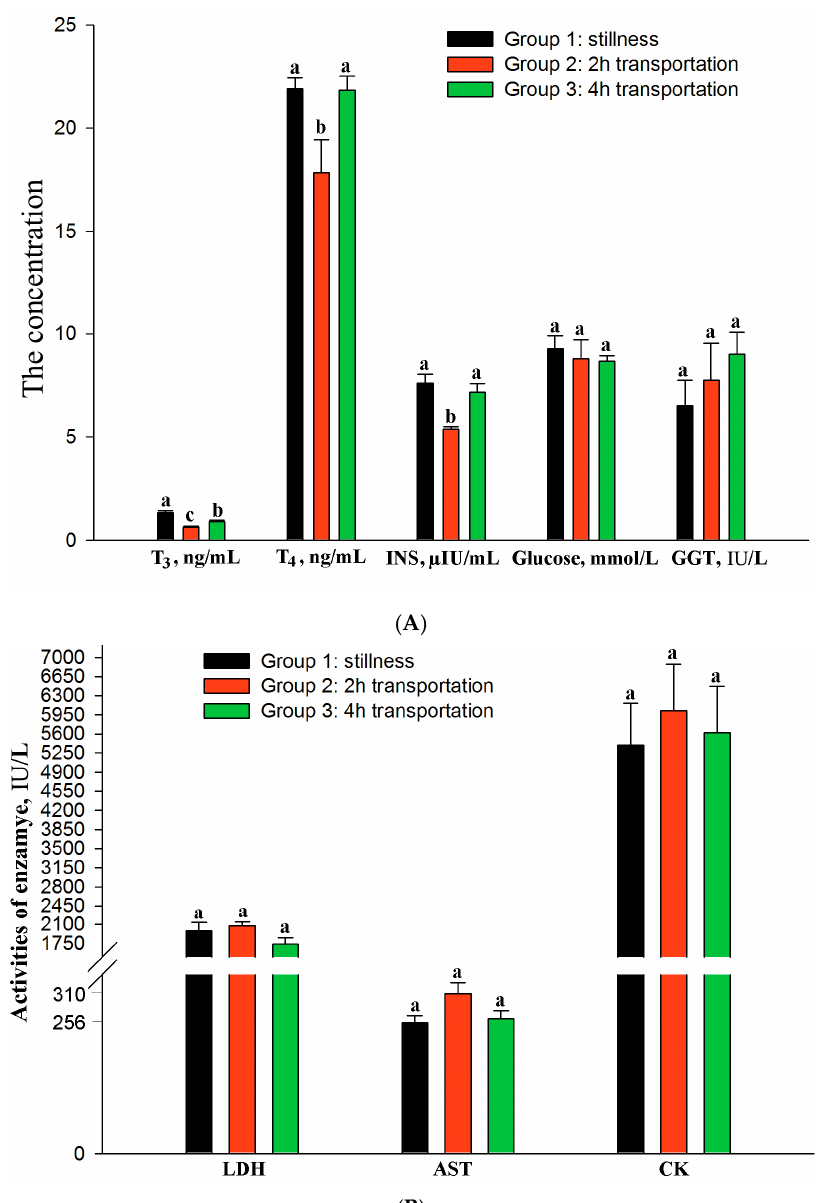
Figure 1. Effect of different transportation treatments on the blood hormones and metabolites of broilers. ( A ) changes of T 3 , T 4 , INS, Glucose, and GGT concentration in the serum and ( B ) changes of LDH, AST, and CK concentration in the serum. Bars within a cluster with different superscripts differ ( p < 0.05). T 3 = triiodothyronine, T 4 = thyroxine, INS = insulin, GGT = γ -glutamyl transferase; LDH = lactate dehydrogenase, AST = asparate aminotransferase, and CK = creatine kinase.